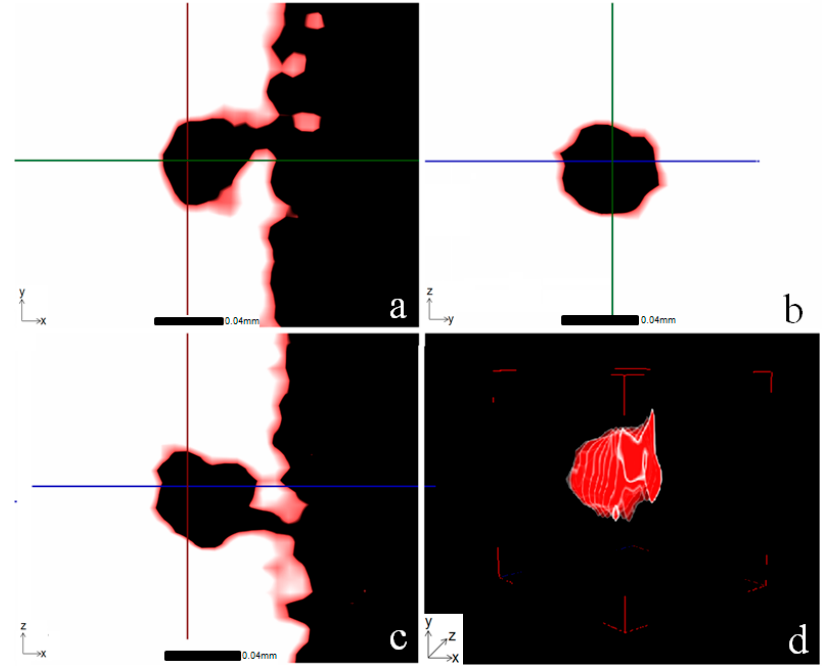
Figure 19. Images of the most prominent surface breaching pore in the EBM disc specimen closest to the fracture region ( a ) z direction; ( b ) x direction; ( c ) y direction and ( d ) full 3D representation, as given in VG studio.